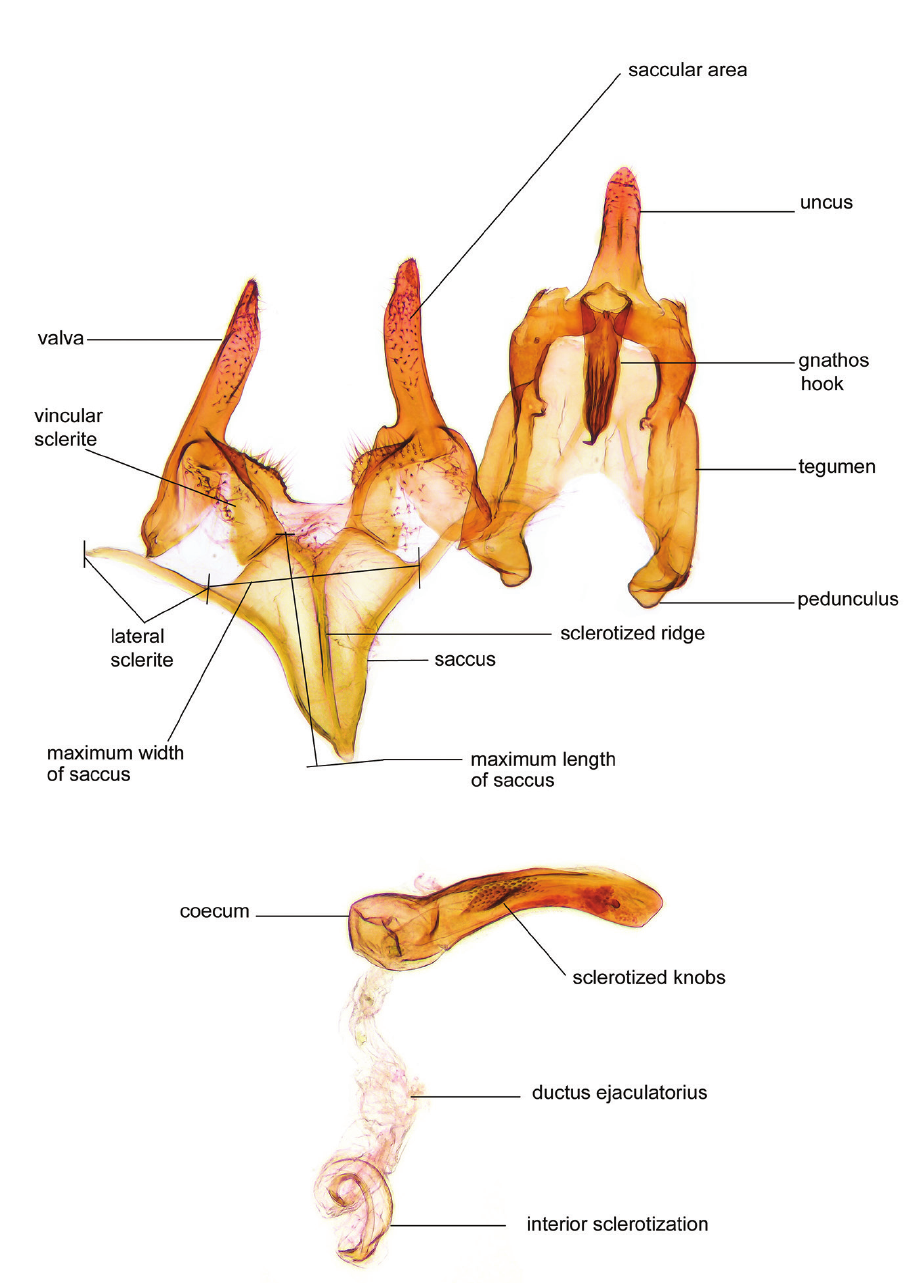
Figure 4. Terminology of important characters in male genitalia of Megacraspedus granadensis sp.